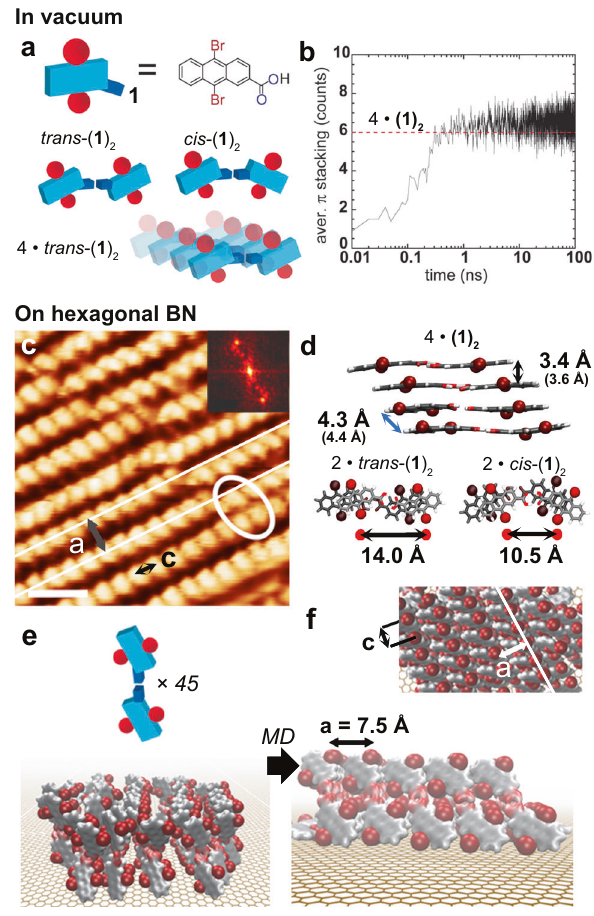
Fig. 2 Simulations and scanning tunneling microscopy detail of the fi rst- layer self-assembled stacks of (1) 2 on boron nitride. a H-bond and π -stacking of 1 may promote densely packed rows. b In vacuo molecular dynamic (MD) simulations of ten molecules of 1 in a 125 nm 3 box show ultrafast propensity towards hydrogen bond dimerization into ( 1 ) 2 and π -stacking: After 1 ns the number of π -stacks (6 – 8) indicate the formation of 4 (cid:129) ( 1 ) 2 stacks. c Ultra-high vacuum scanning tunneling microscopy (UHV STM) data at ~20 K reveals supramolecular structures with periodicity c = (3.5 ± 0.2) Å on BN/Cu(111). Scale bar 1 nm. STM parameters I t = 80 pA, V s = 1.0 V. In the straight pattern the interrow distance is a = 6.4 Å. d Dispersion-corrected density functional tight binding (DFTB) optimization of a 4 (cid:129) ( 1 ) 2 stack extracted from the MD simulations, containing two stacks of trans-( 1 ) 2 and two of cis-( 1 ) 2 with d = 3.4 Å. The numbers in parenthesis refer to calculations employing a Lennard-Jones potential. e , f Molecular dynamics of 45 upstanding edge-on species of ( 1 ) 2 on BN reveals self- assembly in regular patterns with an interrow distance of a = 7.5 Å, c = 3.7 Å. Inset: Top-view of the assembly after 10